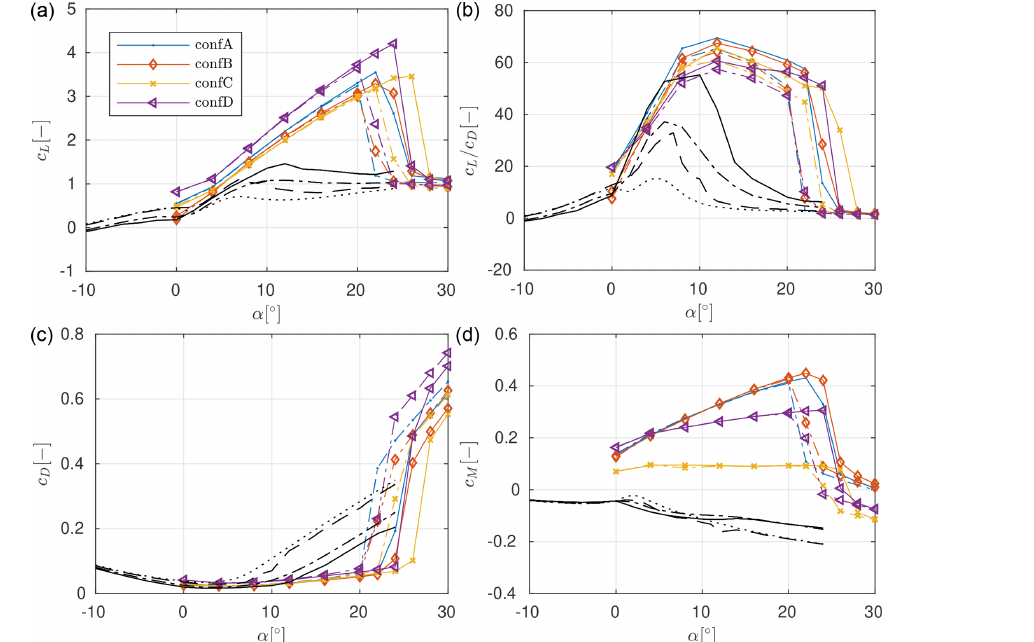
Figure 11. Lift (a) , glide ratio (b) , drag (b) , and pitching moment (d) polars as obtained from CFD for the slat configurations optimized for maximum aerodynamic efficiency using the auxiliary design strategy. The coefficients for the clean ( − ) and tripped ( − . ) DU40 profile only as well as the clean ( −− ) and tripped ( ·· ) FFA48 base profile only are shown as